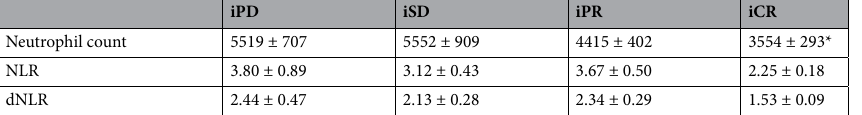
Table 3. Analysis of the relationship between neutrophils and lymphocytes before the start of immunotherapy with CPIs. Neutrophil count (µL); NLR neutrophil-to-lymphocyte ratio (neutrophils/lymphocytes), dNLR derived neutrophil-to-lymphocyte ratio [neutrophils/(leukocytes-neutrophils)]. Best overall response according to iRECIST criteria: iPD, progressive disease (n. 10 patients); iSD, stable disease (n. 13 patients); iPR, partial response (n. 14 patients); complete response, iCR (n. 7 patients). Data are expressed as mean value ± standard error of the mean (SEM). * p = 0.043 iCR versus iPD, assessed by Mann–Whitney U